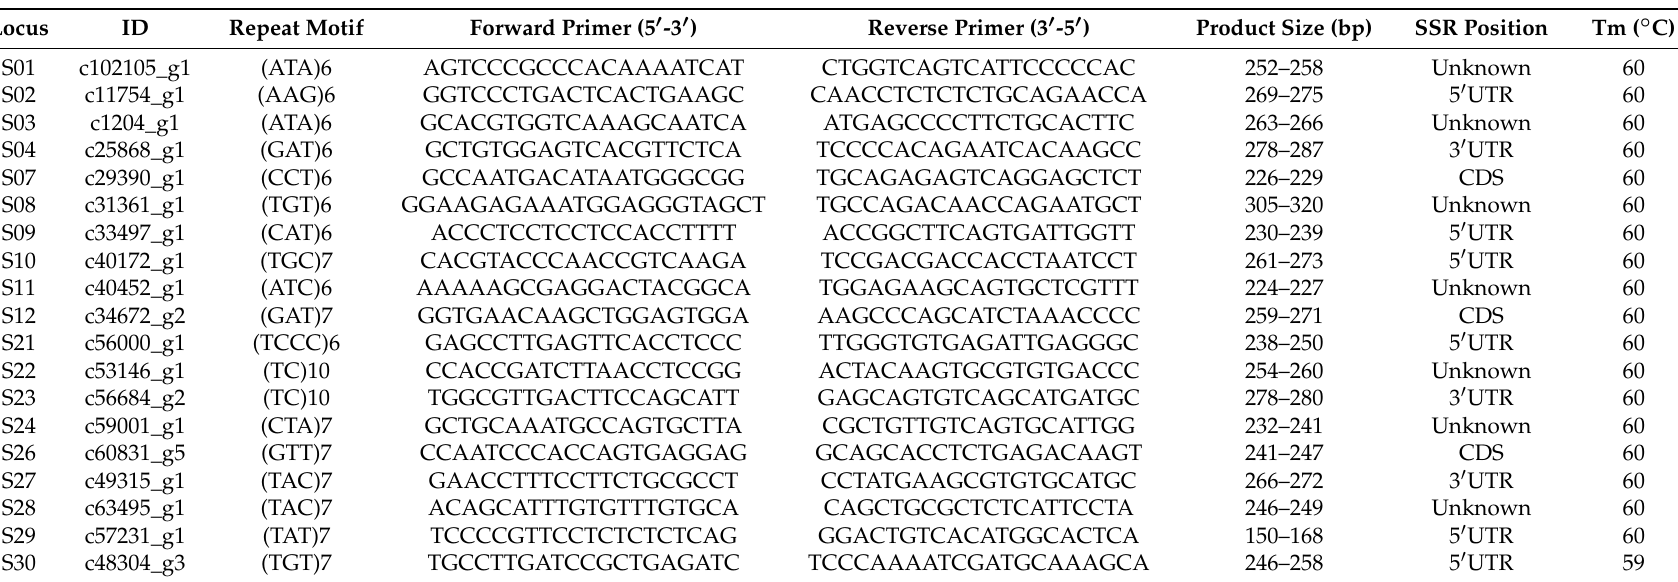
Table 2. Characteristics of 19 SSR (simple sequence repeat) markers developed for D. odorifera